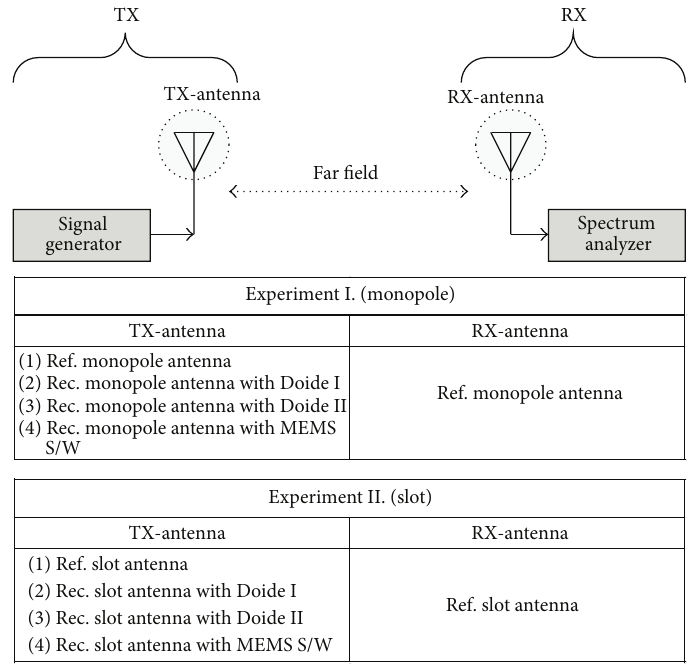
Figure 1: RF performance analysis of reconfigurable antennas with RF switches in the far-field